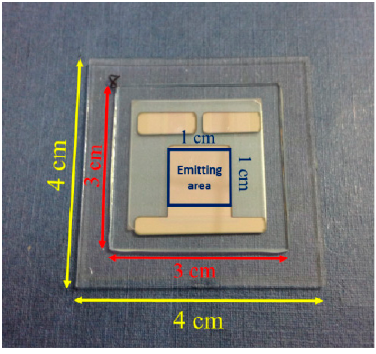
Figure 3. Green OLED sample.